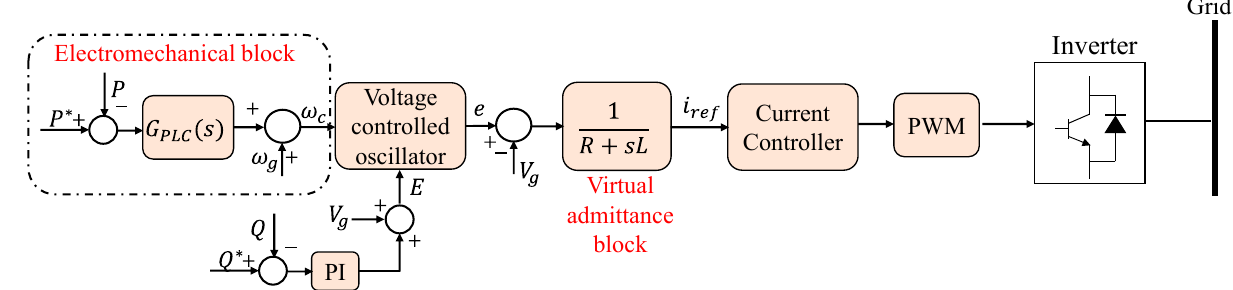
Figure 11. Synchronous power controller (SPC) control diagram [6].